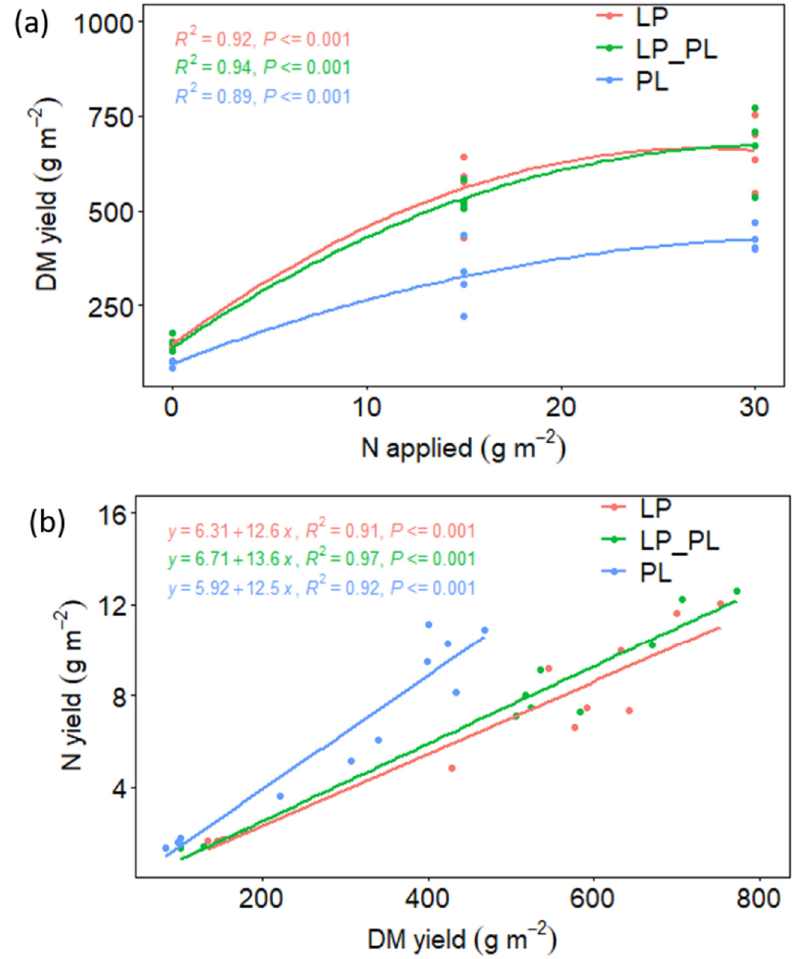
Figure 1. Graphs showing ( a ) the dry matter (DM) yield of pastures in response to varying N rates and ( b ) the linear relationships between the DM yield and nitrogen yield affected by the different swards.